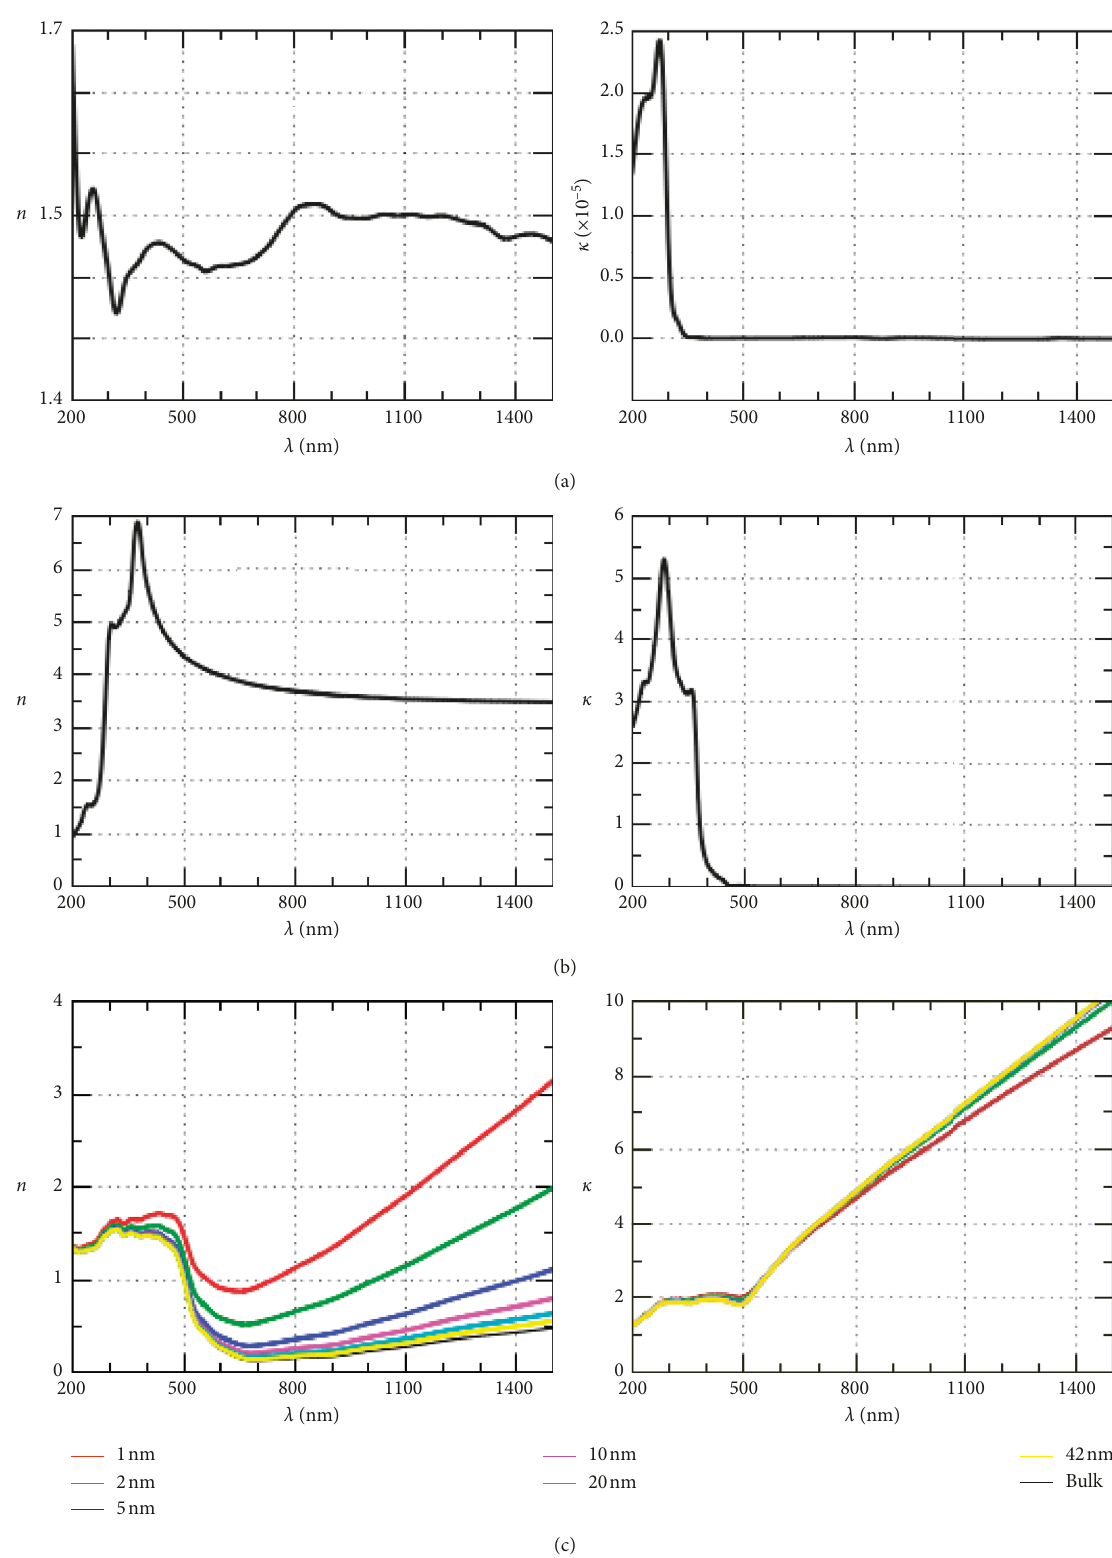
Figure 2: The refractive index n and the extinction coefficient κ of bulk silica (a), bulk silicon (b), and gold nanoparticles